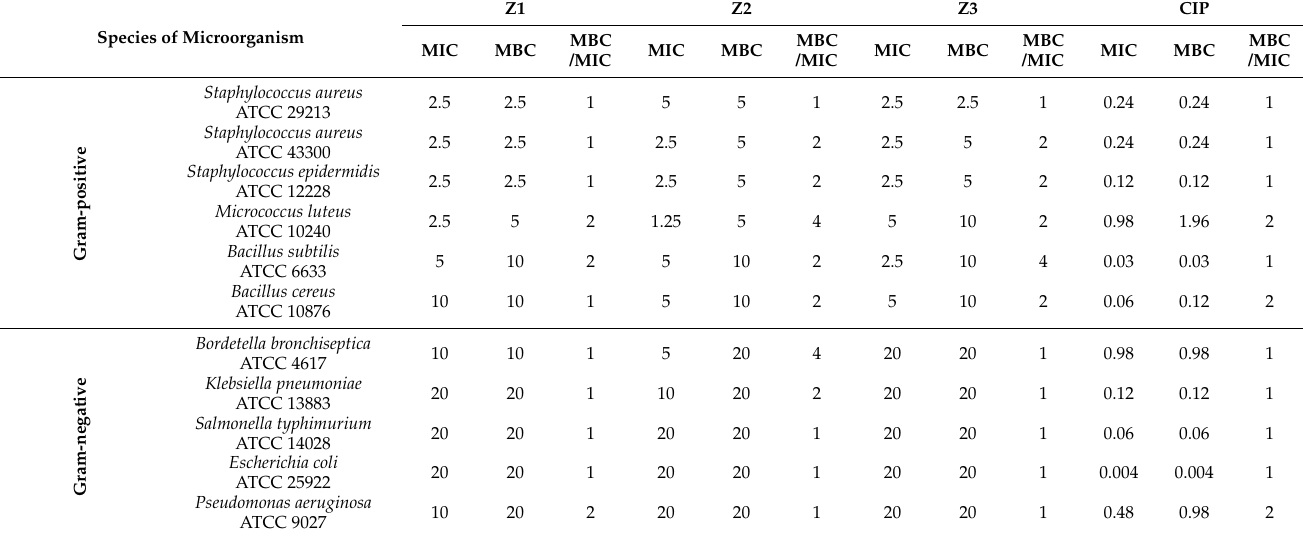
Table 2. The activity data of Z. bungeana extracts expressed as MIC (Minimum Inhibitory Concen- tration), MBC (Minimum Bactericidal Concentration) [mg/mL] and MBC/MIC value against